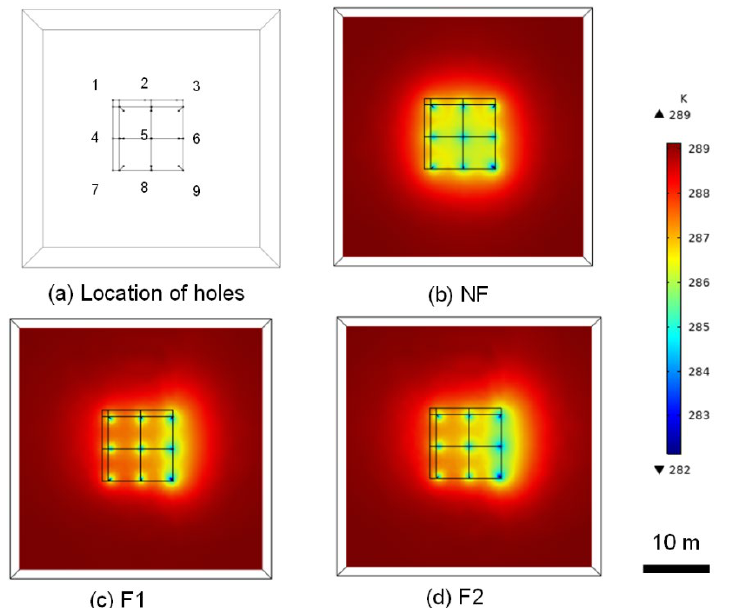
Figure 9. The temperature field on the X-Y plane at Z = − 47.5 m (fracture plane) at the 26th month: (NF) non-fracture rock mass; (F1) rock mass with one horizontal fracture; (F2) rock mass with two horizontal fractures.